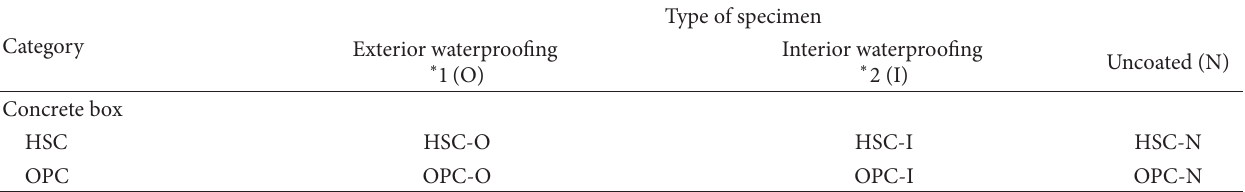
Table 2: Details about mortar specimens by temperature.